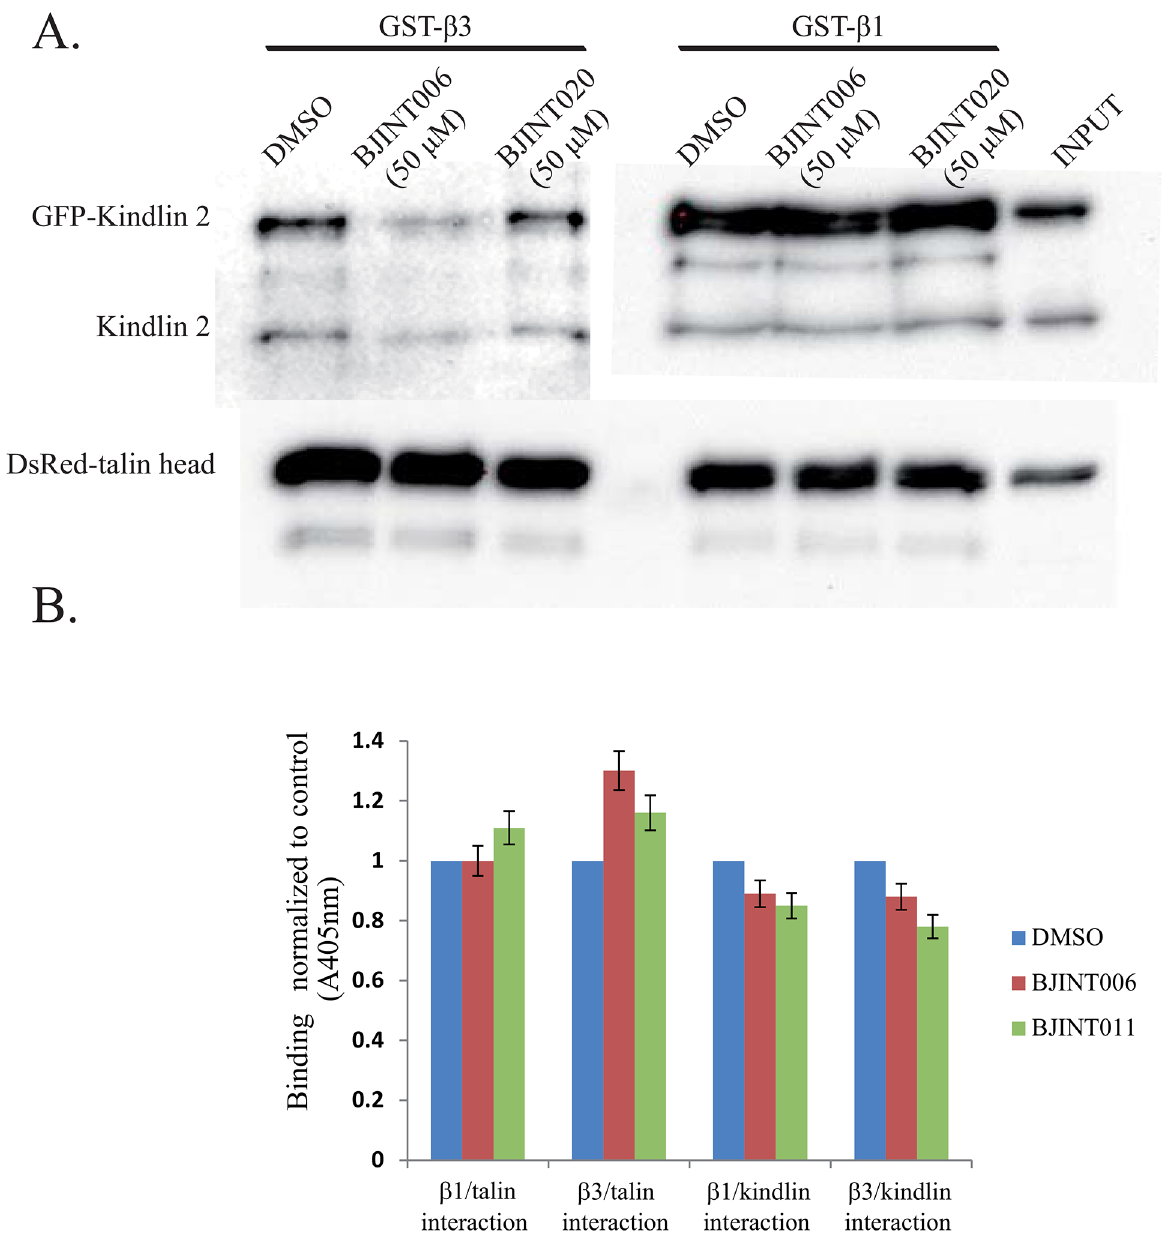
Fig 5. BJINT derivatives interfere with the binding of talin and kindlin to integrin cytoplasmic tails. (A) Pull-down assays with GST- β 3 and GST- β 1 tails bound to glutathione beads incubated for 4 h with cells lysates. Associated talin head and kindlin was revealed Western blotting using anti kindlin and anti talin head antibodies. Chemiluminescence was monitored by Biorad imager. (B) Summary of 6 solid phase binding assays of biotinylated integrin tails to talin (F2/F3 domain) and kindlin-2 (FERM domain) under non saturable conditions and in the presence of 50 μ M BJINT